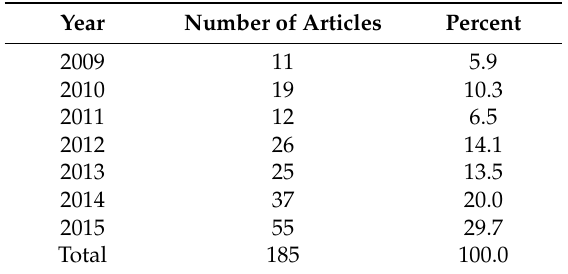
Table 2. Number and percentage of articles published by year, 2009–2015.